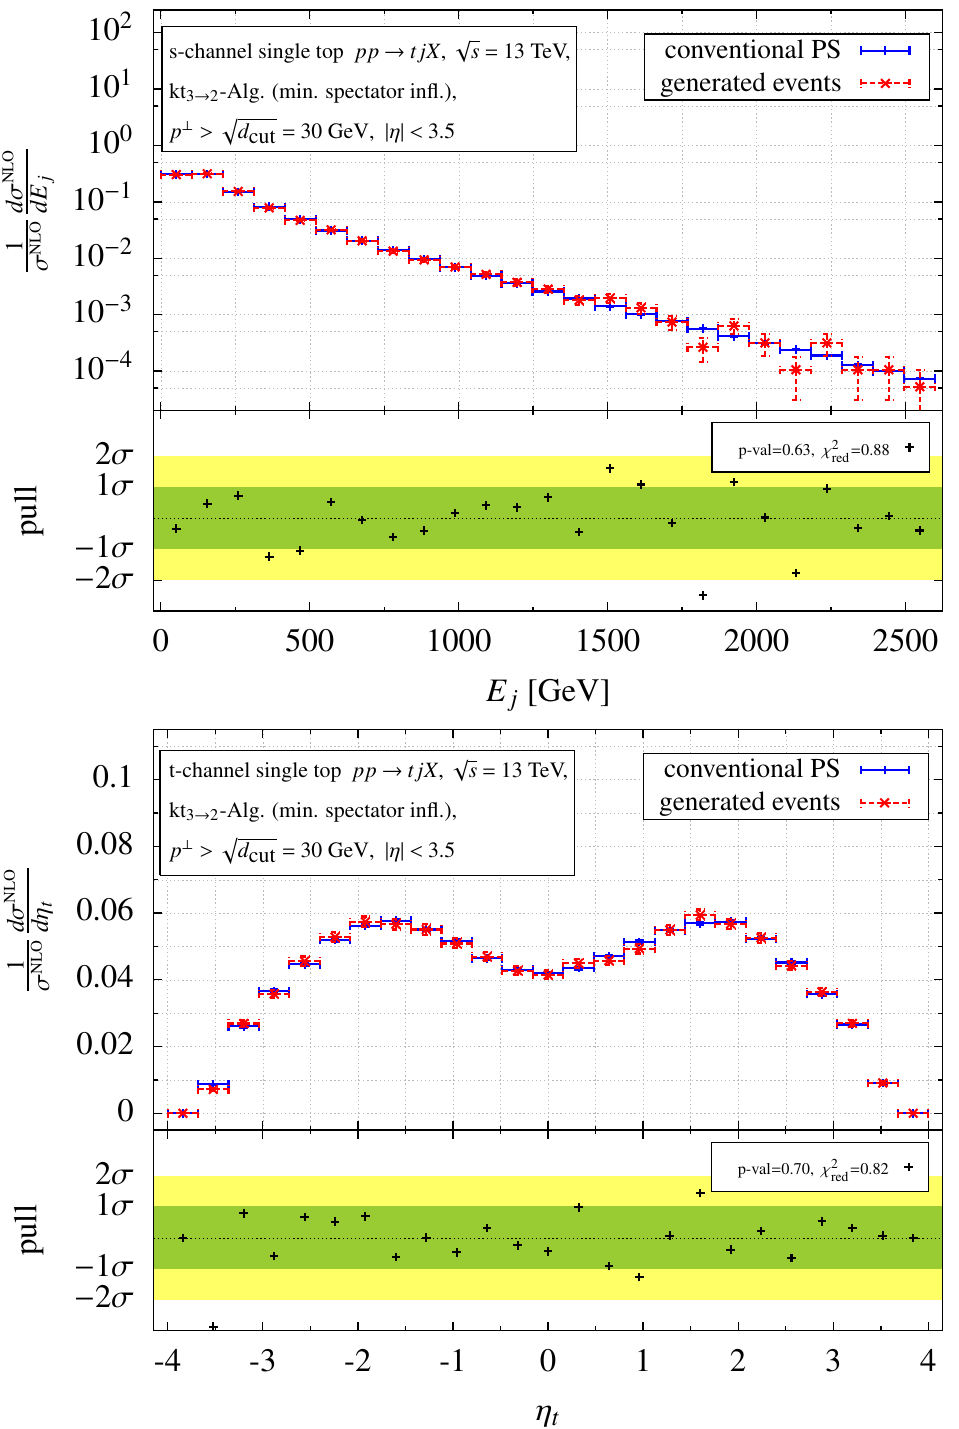
Figure 8 . Energy distribution of the light jet from inclusive s -channel single top production and pseudo rapidity distribution of the top-tagged jet from inclusive t -channel single top production calculated using a conventional parton level MC (blue, solid) compared to histograms (cid:12)lled with generated NLO events (red, dashed).